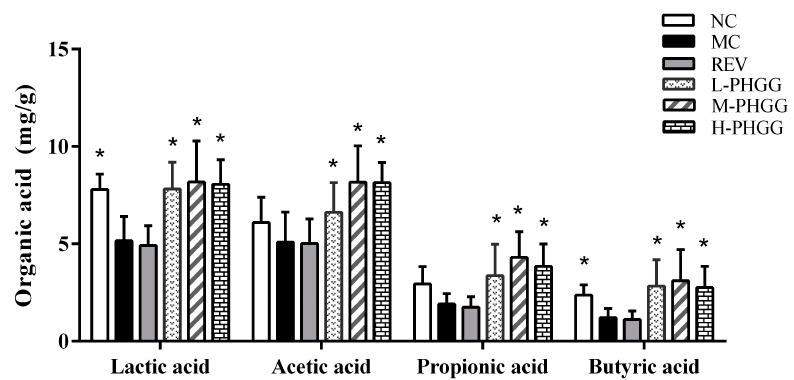
Figure 4. The concentration of lactic acid, acetic acid, propionic acid, and butyric acid. Statistical significance between the model control group and the other groups was determined by the Kolmogorov–Smirnov test and Levene’s test for hypotheses of normality and variance homogeneity, followed by Student’s t -test or Mann–Whitney’s U non-parametric test. * p < 0.05 compared with the model control group. NC, normal control (saline); MC, d -gal model control (saline); REV, resveratrol (20 mg / kg / day); L-PHGG, 500 mg / kg / day; M-PHGG, 1000 mg / kg / day; H-PHGG, 1500 mg / kg / day.